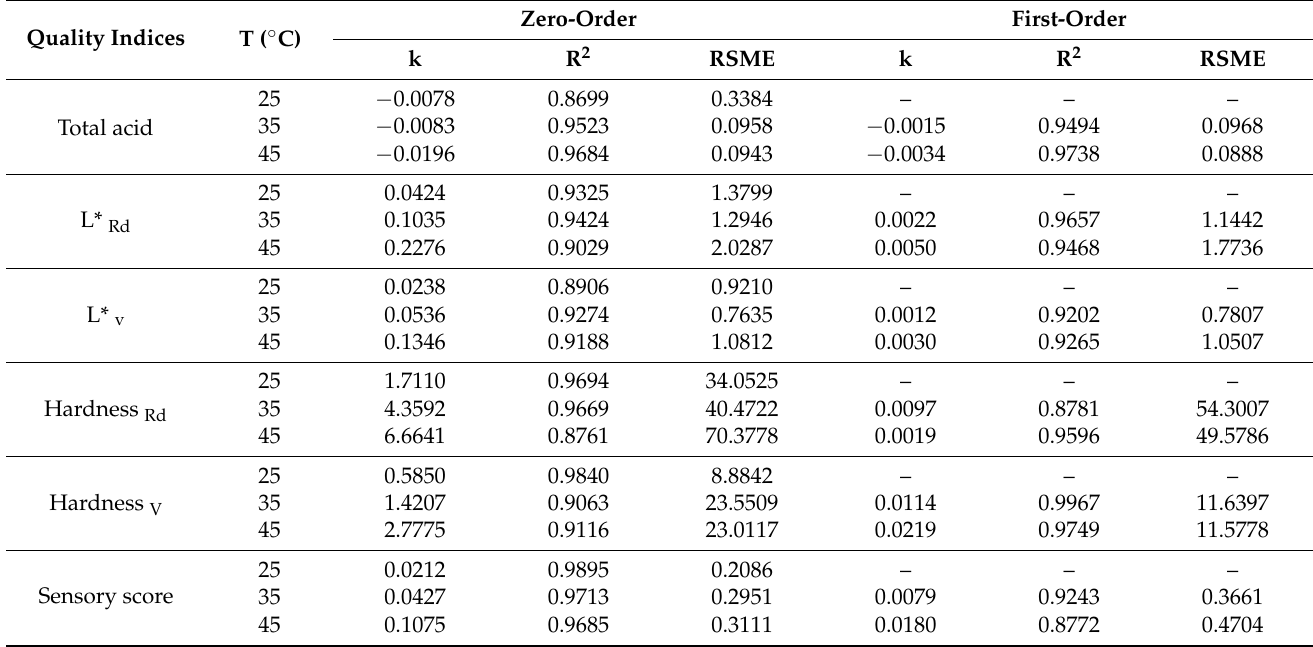
Table 2. Reaction order estimation of quality indices based on the coefficient of determination (R 2 ) and root mean square error (RMSE) from the zero- and